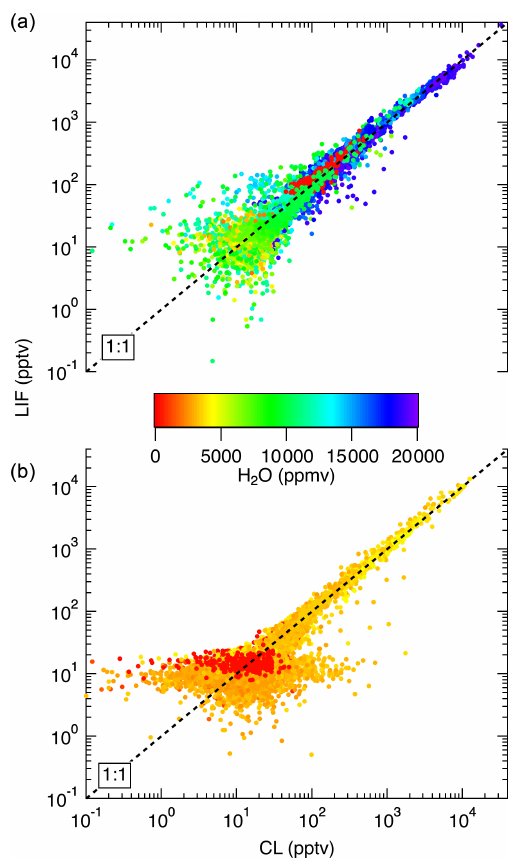
Figure 14. Comparison between LIF and CL measurements from the NASA DC-8 during FIREX-AQ. (a) shows a comparison of the 1s measurements from the flight on 22 July. This flight sampled air from the Los Angeles basin; the San Joaquin Valley; and the free troposphere transiting from Palmdale, CA, to Boise, ID. (b) com- pares data from a flight on 25 July, focusing on wildfire smoke sam- pling. Differences in LIF precision between these flights are due to unusually low laser power on the 22 July